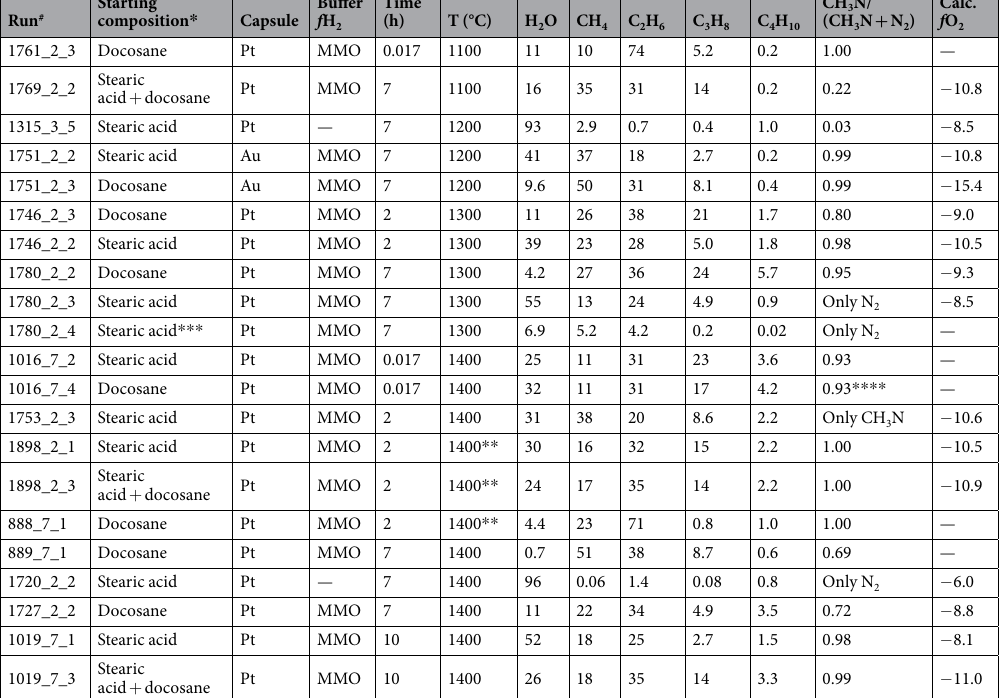
Table 2. Experimental conditions and concentrations of main species (rel.%) in quenched C-O-H-N fluids synthesised at 6.3 GPa. Full compositions are given in Supplementary Table 1. MMO is Mo-MoO 2 buffer. CH 3 N/(CH 3 N + N 2 ) is normalised peak area ratio A(17 + 29 m/z)/(A(17 + 29 m/z) + A(28 m/z)). * All starting compositions include graphite, at 10/1 to fluid generating material. ** Fluid cooling at 1 deg/s. *** Very little gas released upon capsule opening. **** NH 3 is main nitrogen